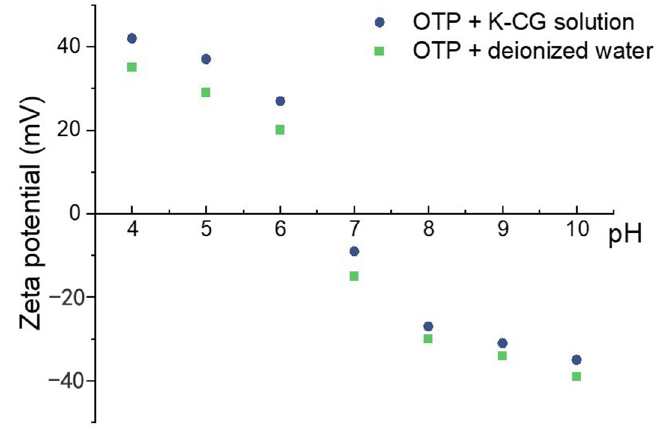
Figure 8. Zeta potential of dispersing OTP in water and K-CG solution.